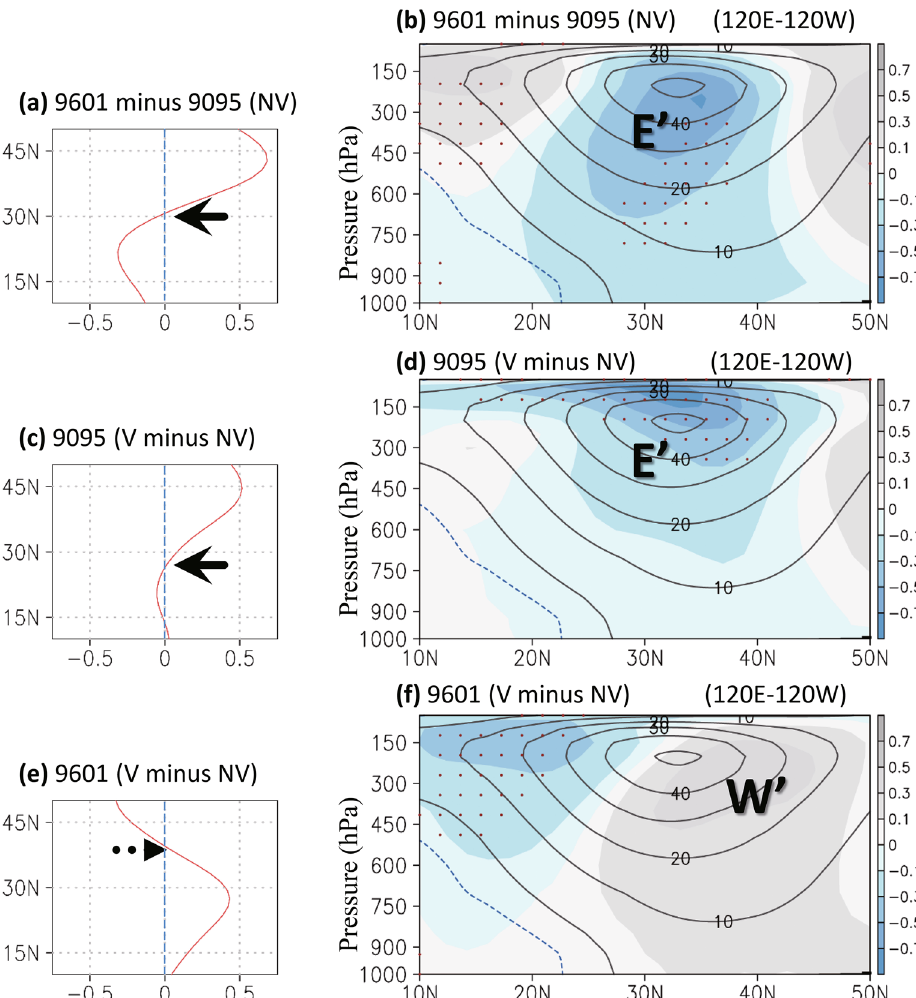
Figure 5. The modeling decadal change (1996–2001 minus 1990–1995) without volcanic forcing from December to February in (a) the zonal mean (120° E–120° W) streamfunction at 300 hPa (unit: 10 6 m 2 s −1 ) and ( b ) the zonal mean of zonal winds in pressure levels. Dots over shading indicate that the difference in streamfunction had a confidence level of 90%. The Figure was generated using software Grid Analysis and Display System (GrADS) Version 2.1.1.b0 (http:// cola. gmu. edu/ grads/ grads.